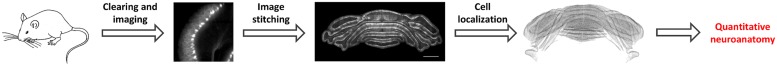
Experimental pipeline for large-volumes quantitative neuroanatomy. After animal fixation, the brain is render transparent and imaged with high-throughput light sheet microscopy. Raw image stacks are then stitched together, and a software for automatic cell localization applied. The resulting cloud of points representing the position of labeled cells can be the starting point for many different quantitative neuroanatomical analysis.